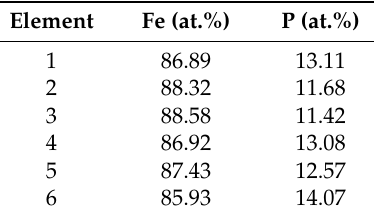
Figure 13. Images of the location of the iron-phosphorus phase. Table 5. Energy dispersive spectrometry (EDS) analysis data of elements in iron-phosphorus phase. Element Fe (at.%) P (at.%)